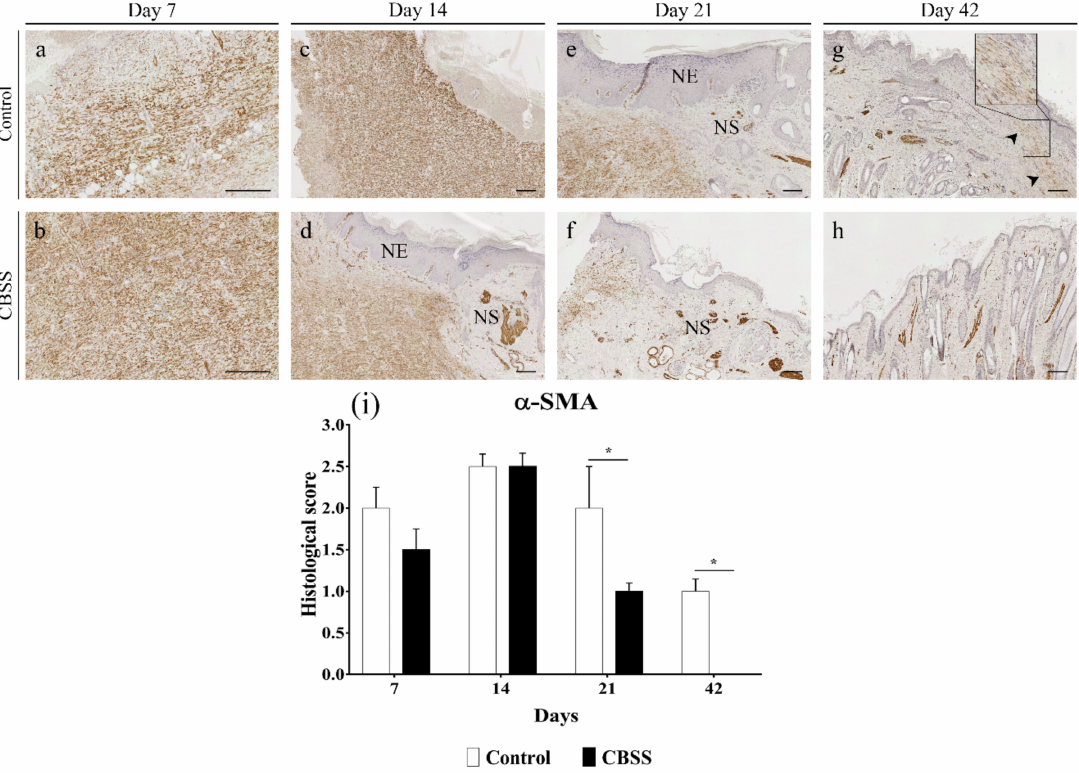
Figure 8. Immunohistochemistry microphotographs for α -SMA immunostaining. Wounds are showed at ( a , b ) 7 days, ( c , d ) 14 days, ( e , f ) 21 days, and ( g , h ) 42 days. ( i ) Semi-quantitative analysis based on the score for presence and orientation of myofibroblasts in wounds at 7, 14, 21, and 42 days. Arrowhead = myofibroblasts in the mature dermis; NE = neoepidermis; NS = neoskin. Scalebar = 200 µ m; inset = higher magnification of the dermal fibrosis. ( i ) Data are expressed as mean ± SEM. Statistical differences were measured between the two experimental groups at the same time point * p <